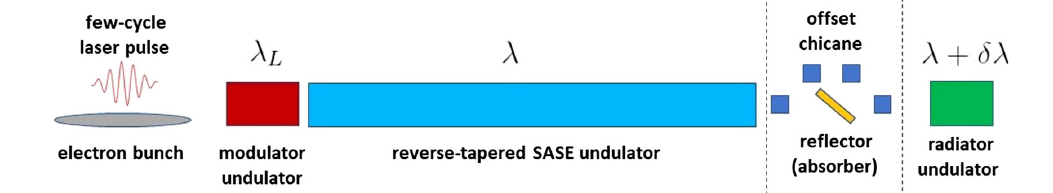
side.FIG. 1. Conceptual scheme for generation of attosecond pulses. Dashed rectangle illustrates a particular realization of suppression (separation) of a radiation background from the SASE